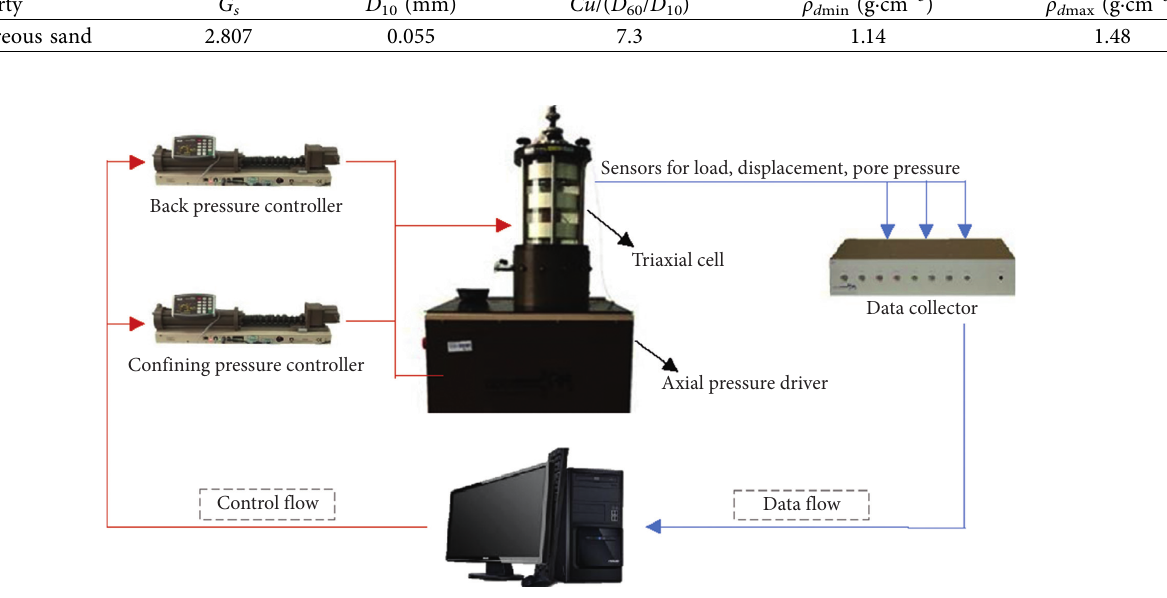
Figure 3: GDS dynamic triaxial test